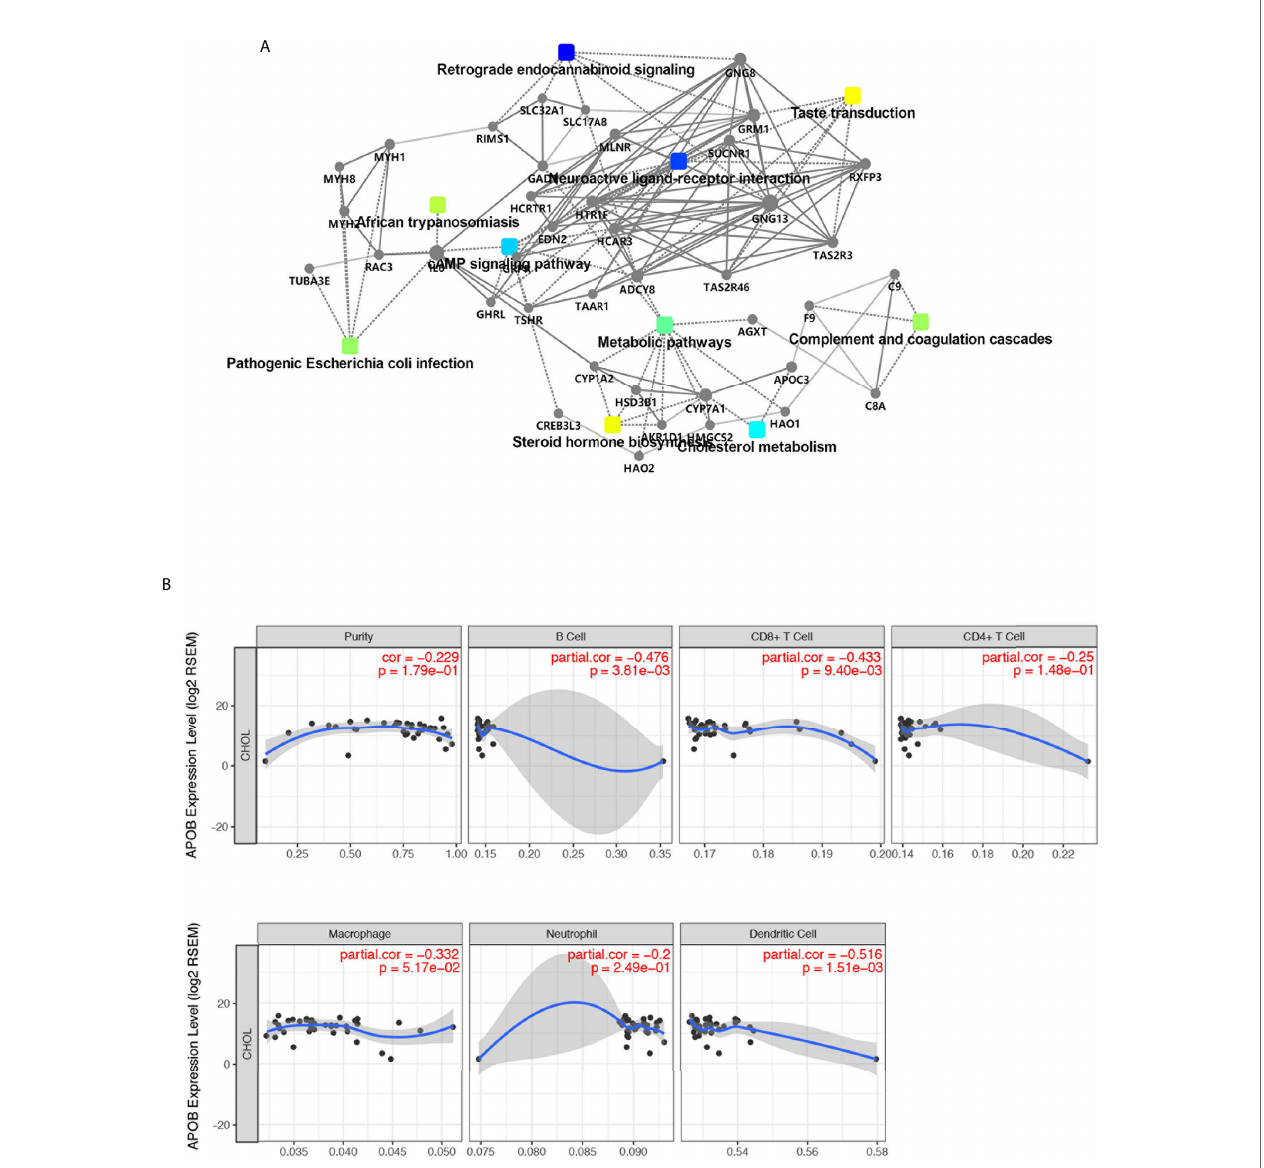
FIGURE 5 | The expression of APOB was related to the immune cell in fi ltration in CCA. (A) The probability of relationship between pathways of DEGs was evaluated by STRING tools. The PPI network was established. (B) TIMER database was used to validate the correlation between APOB expression and the level of immune cell in fi ltration in CCA. Followed by the up-regulation of APOB, the purity of B cells, CD8+ T cells, CD4+ T cell, macrophage, neutrophil, dendritic cells were